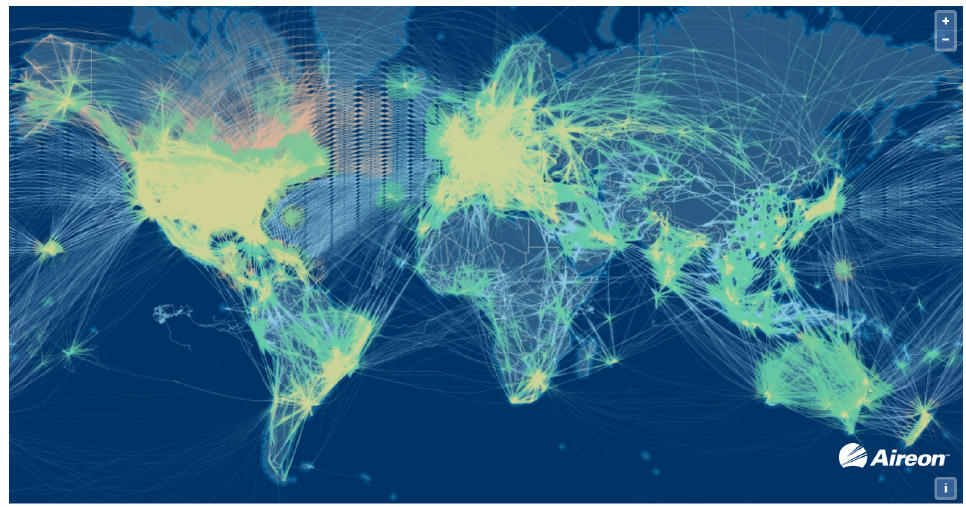
Fig. 3. A screenshot of an interactive airspace map monitored by